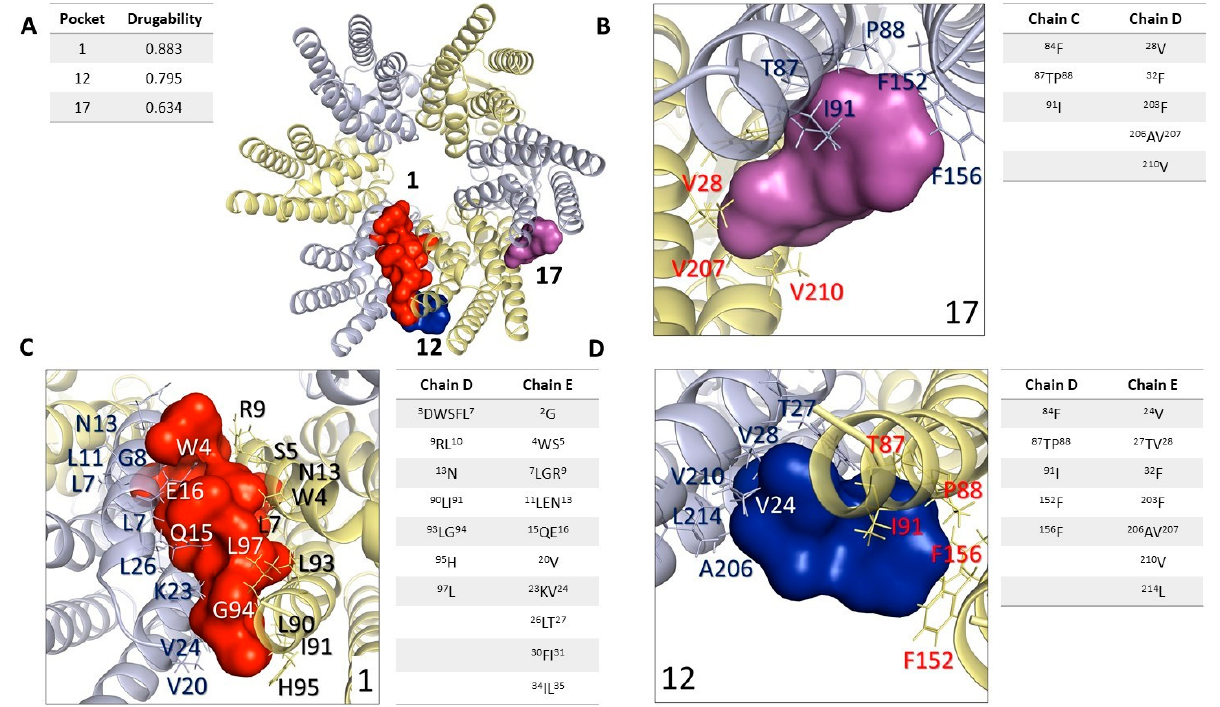
Figure 5. Cavities identified in the hemichannel of connexin 46. Hemichannel is visualized in a 90° rotation (x-axis). ( A ) Structure of HC-Cx46 representing the three best cavities; cavity 1 = 0.795, cavity 12 = 0.883, and cavity 17 = 0.634 calculation carried out with Fpocket. ( B – D ) The chain structure of Cx46 represents the three best cavities found by Fpocket. Summary table, detailing drugability score, amino acid residues, chains, and domains.